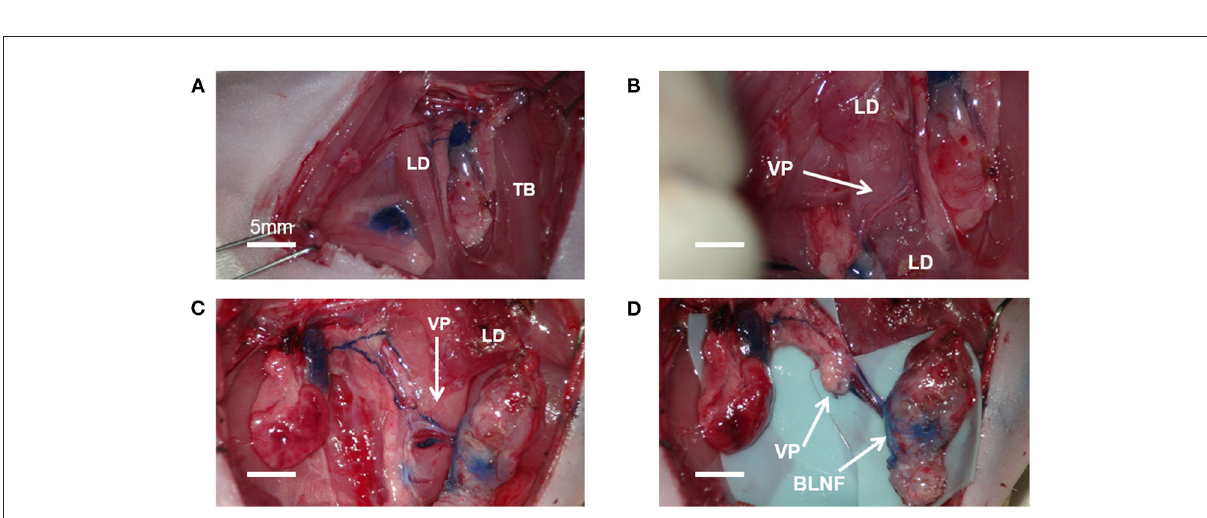
FIGURE2 Microsurgical procedure for brachial lymph node flaps (BLNFs). (A) BLNF is located between the triceps brachii (TB) and latissimus dorsi (LD). (B) The vascular pedicle (VP) was exposed by cutting part of the latissimus dorsi. (C) A complete release of the vascular pedicle in BLNF. (D) Complete elevation of the